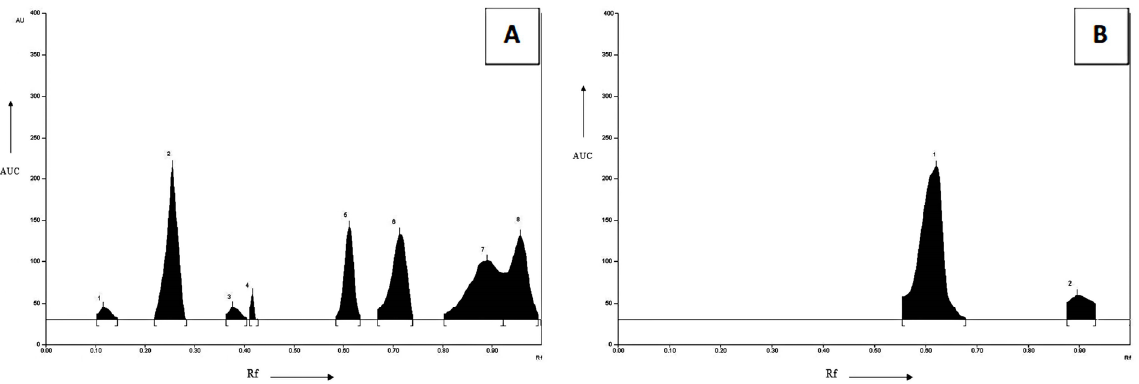
Figure 1. ( A ) HPTLC fingerprinting profile of B. diffusa extract. The peaks obtained after HPTLC fingerprinting of B. diffusa extract were similar to the peaks of phytoconstituents (Punarnavine and boeravinone B). Some additional peaks were also obtained; these may be a mixture of alkaloids. ( B ) HPTLC fingerprinting of B. diffusa extract. At 366 nm, the peaks obtained were nearly similar to the peaks of phytoconstituents studied